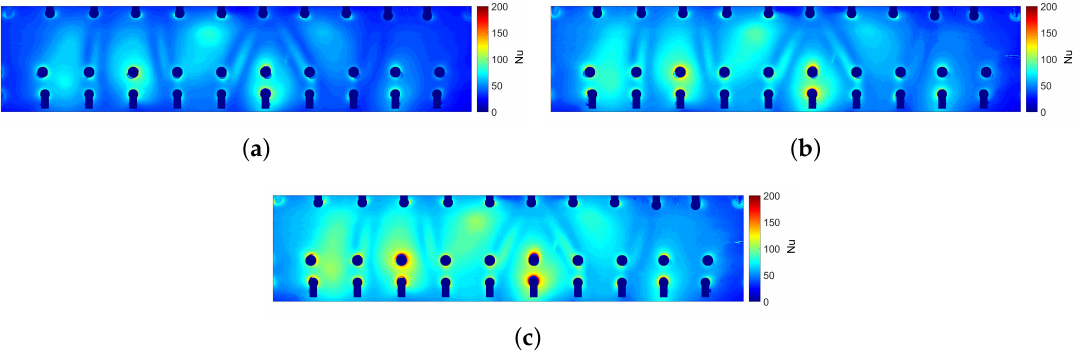
Figure 7. Comparison of measured Nusselt number distributions for geometry 2 with Re = 13,000, 17,500 and 22,000. ( a ) Re = 13,000; ( b ) Re = 17,500; ( c ) Re = 22,000.